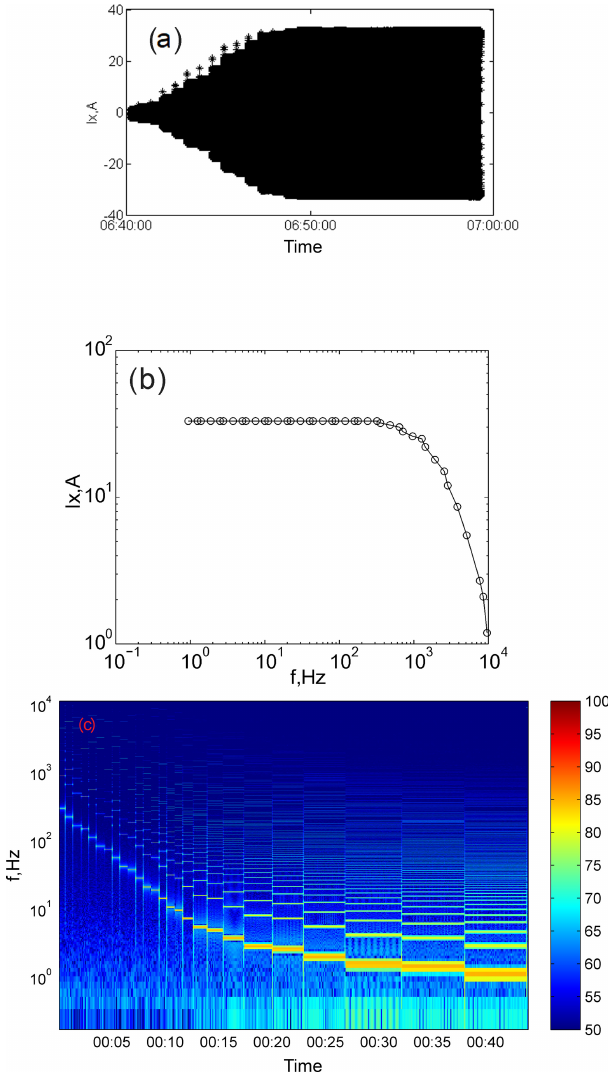
Figure 7. (a) Current time series as one complete cycle (CSAMT mode, duration 50min, 9600 to 0.9375Hz, 2 to 30Ap); (b) fre- quency stack result; and (c) time–frequency spectrum (CSAMT